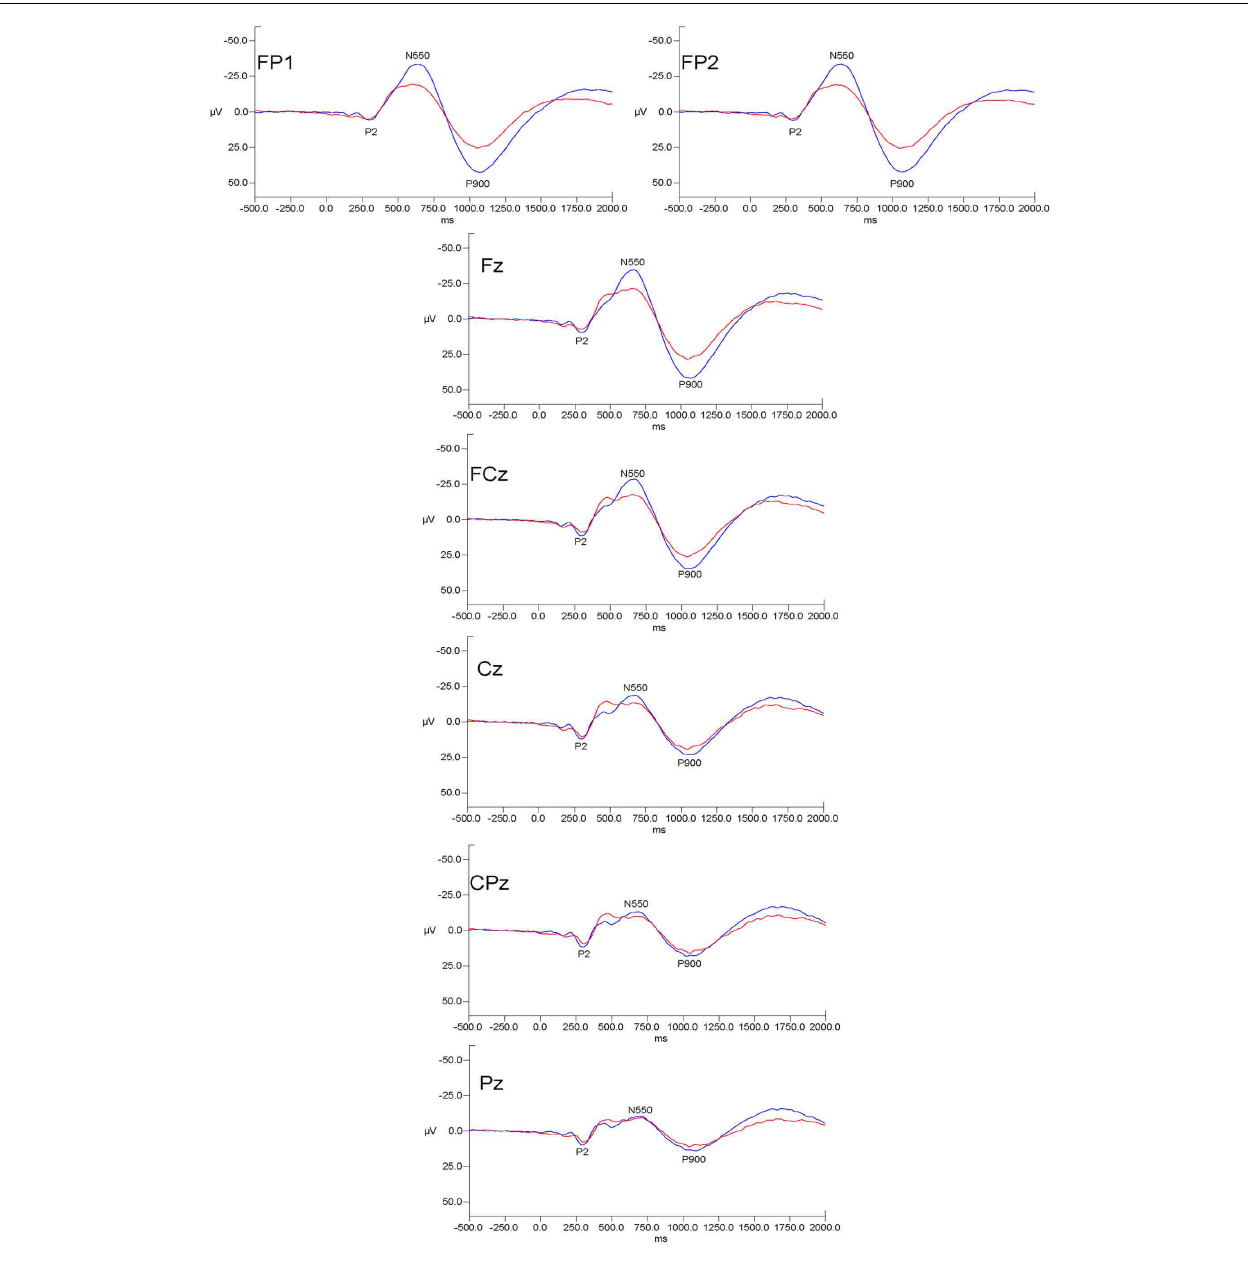
voltages up the Y axis.The pattern of results indicates that initial-follow-up differences were prominent over frontal and frontal–polar sites but were diminished at more posterior scalp